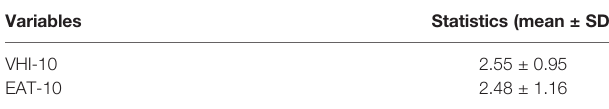
TABLE 3 | Functional outcomes of the study population.